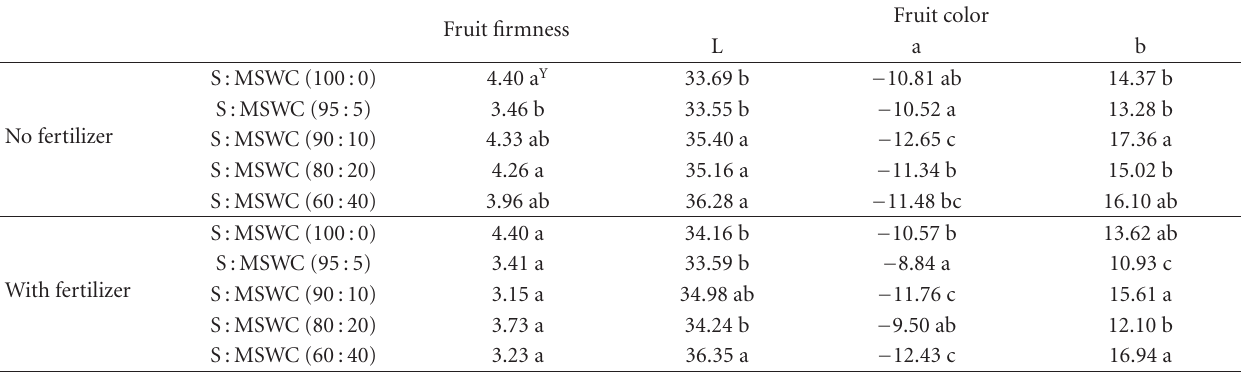
Table 3: E ff ects of municipal solid waste compost (MSWC) into soil (S) with or without fertigation on fruit firmness (N) and fruit color (L, a, and b values) in greenhouse pepper crop.